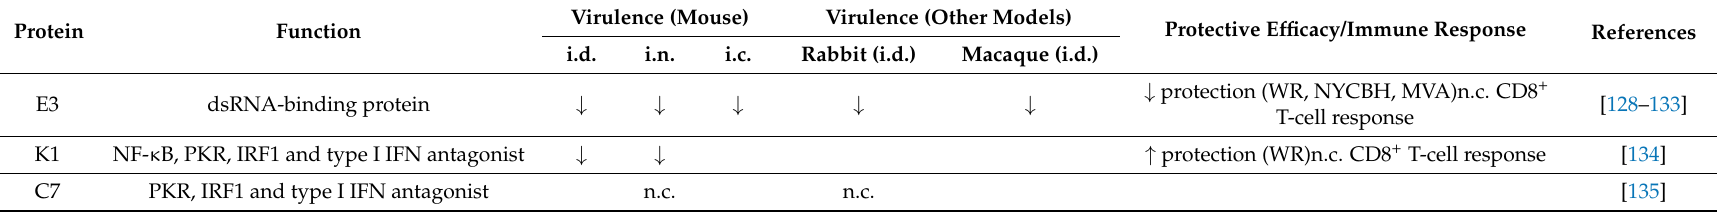
Table 1. VACV strains lacking host range proteins that have been tested for virulence and/or immunogenicity.